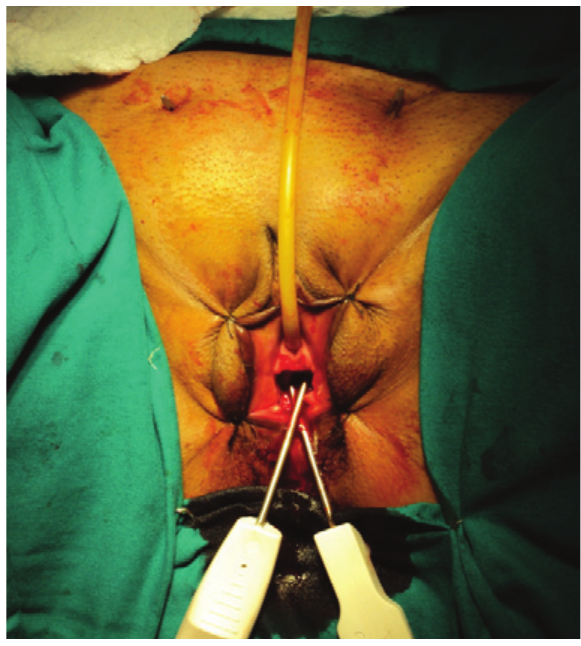
Figure 2 - Stamey needles